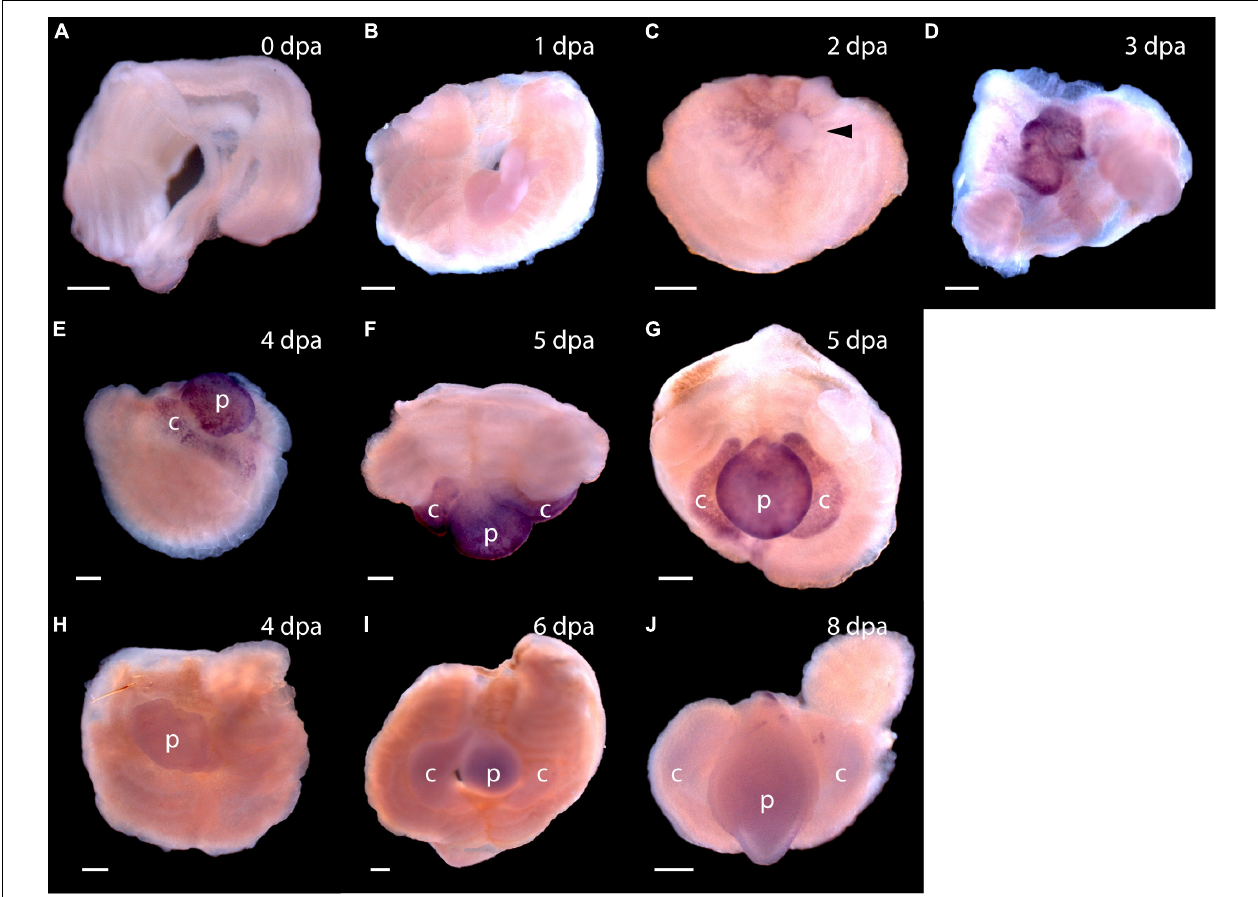
FIGURE 5 | Expression of stem cell genes Pf-SoxB1 and Pf-Klf1/2/4 during head regeneration. (A–G) Whole mount in situ hybridization of Pf-SoxB1 . At 0 days post-amputation (dpa) (A) and at 1 dpa (B) , no signal is detected. (C) At 2 dpa, a fine, reticulated signal appears at the swollen edges of the cut body wall being pulled into the closing wound. The arrowhead marks an unlabeled, rounded bleb of swollen body wall not yet pulled into the wound. (D) At 3 dpa, a strong signal appears only in the blastema. This blastema appears as two parts. These parts usually merge into one as they grow. (E) At 4 dpa, signal appears only in blastema with signal showing in the nascent collar as well as in the proboscis. (F) At 5 dpa, dorsal view, signal appears only in the blastema with no signal along the dorsal midline where Pf-Pou3 and Pf-Msxlx signals are prominent (see Figures 4A–G for Pf-Pou3 and Figures 4F–H for Pf-Msxlx ). (G) At 5 dpa, there is signal throughout the blastema, but no signal in the dorsal trunk. Dorsal is up in all frames except (F) where the dorsal surface is facing the viewer. (H–J) In situ hybridization of Pf-Klf1/2/4 . (H) At 4 dpa, (I) at 6 dpa, and (J) at 8 dpa, definite, but weak signal spread generally throughout the blastema and regenerating tissue. p, nascent proboscis; c, nascent collar. Scale bars = 0.25